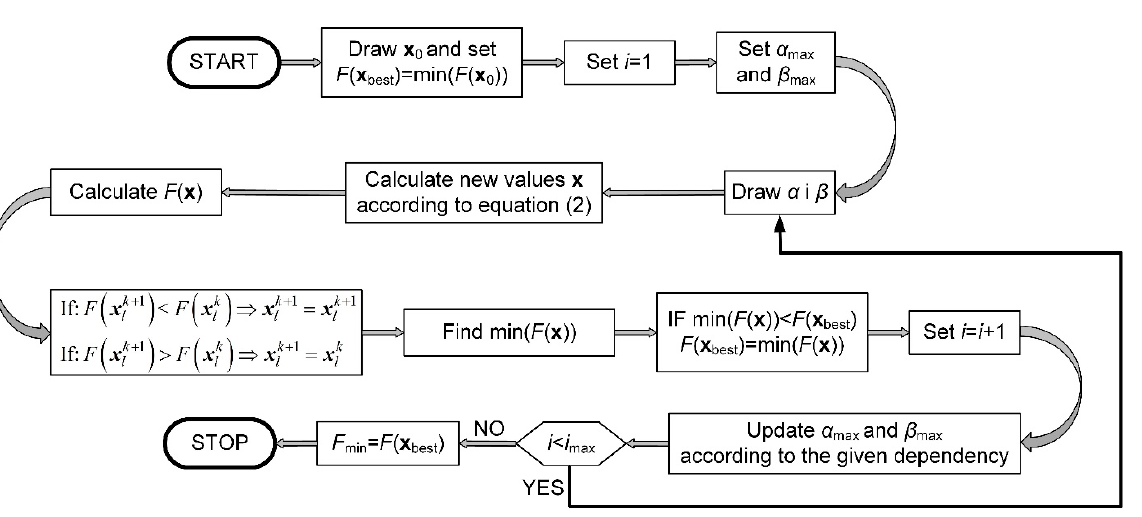
Figure 2. Block diagram of the AIG algorithm ( k is the iteration number).